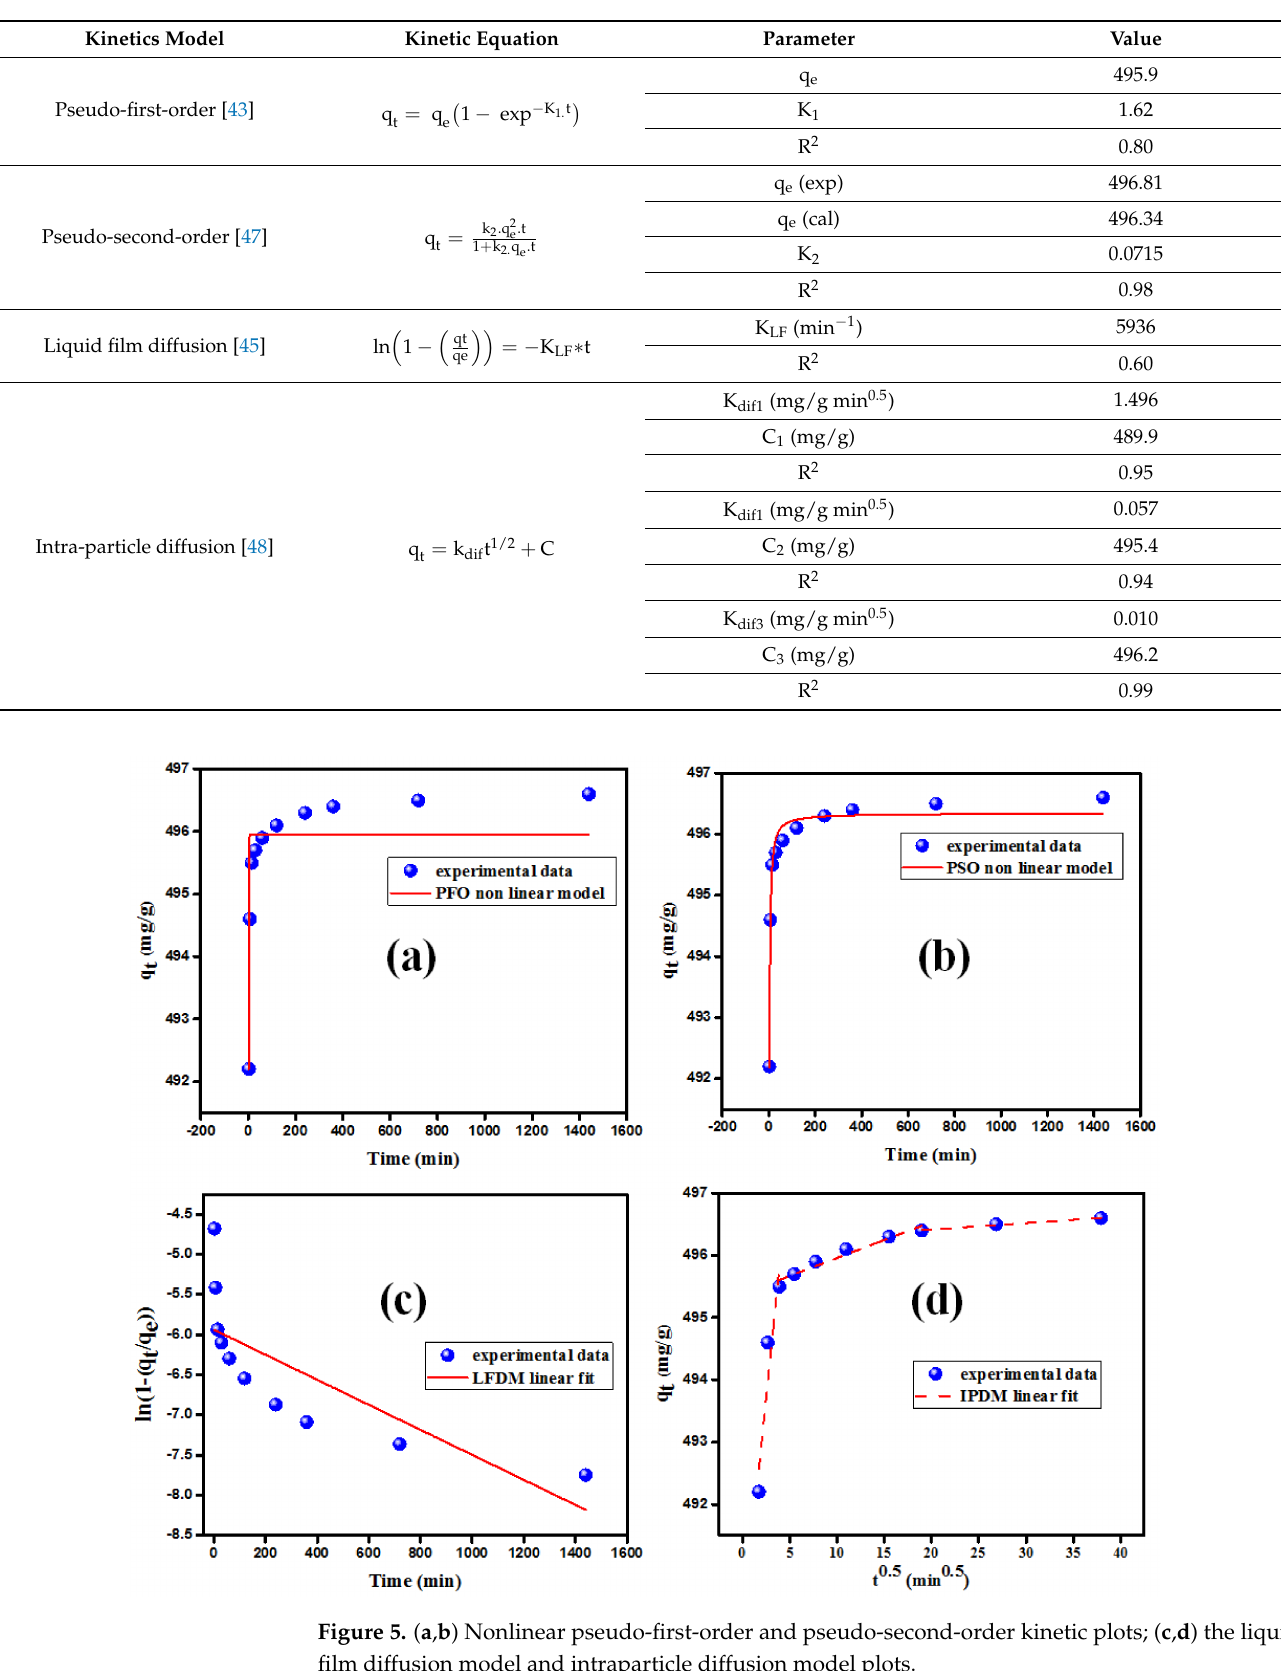
Table 1. The kinetic parameters for BF sorption on MgO nanoparticles.